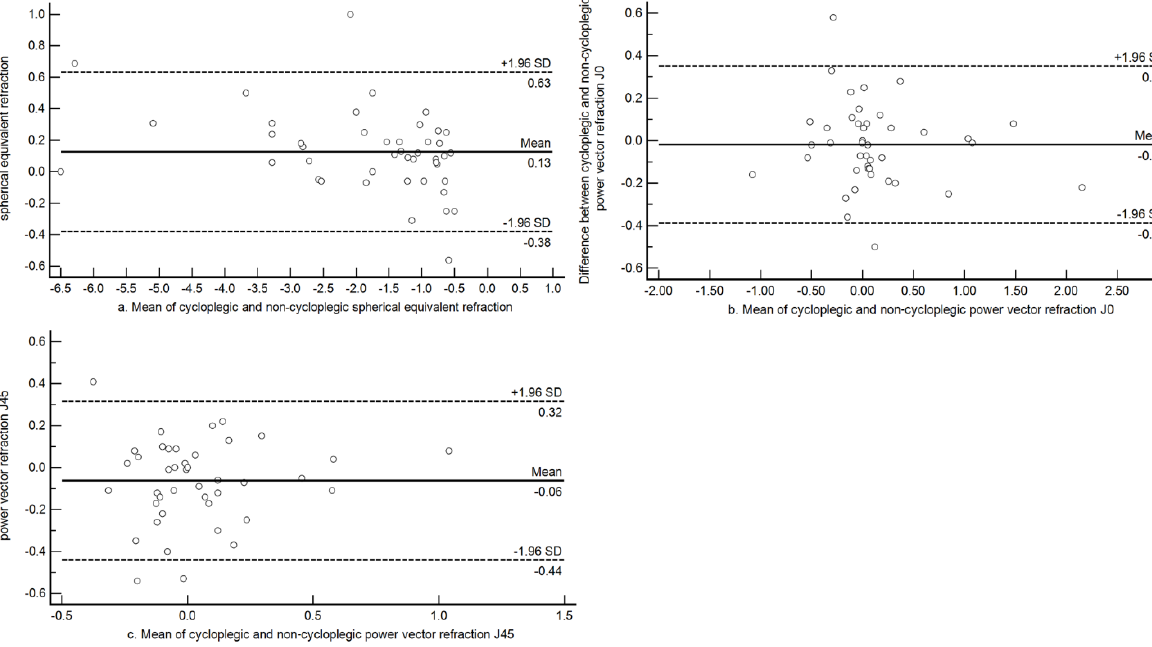
Figure 2. Bland-Altman plot assessing agreement between cycloplegic and non-cycloplegic refraction estimates for spherical equivalent refraction, J0 and J45 among subjects with myopia. ( a ) Agreement between cycloplegic and non-cycloplegic refraction for M; ( b ) agreement between cycloplegic and non-cycloplegic refraction for J0; ( c ) agreement between cycloplegic and non-cycloplegic refraction for J45. The central solid line represents the mean difference between the two measurements and the broken lines above and below represents the 95% Limits of Agreement.